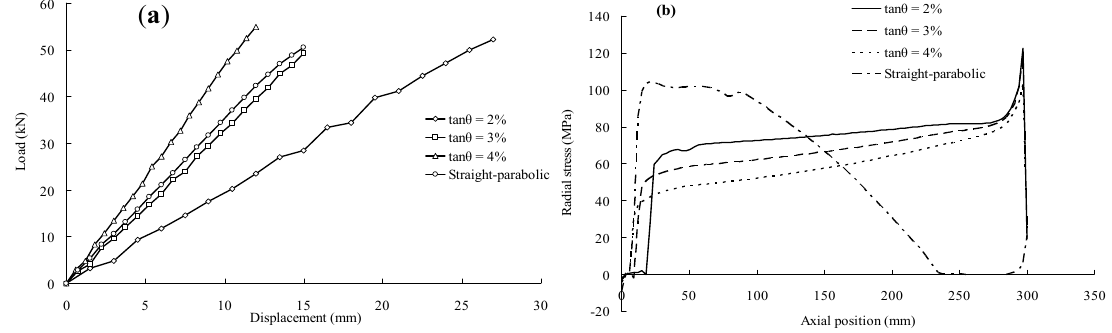
Figure 11. ( a ) The loading curve of inner cone anchor with a varying inclined angle; ( b ) the radial stress distribution of inner cone anchor with a varying inclined